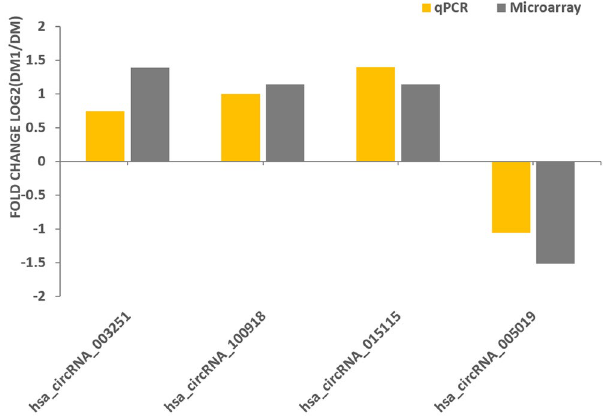
Figure 2. Validation of the four differential expression circRNAs. The expression levels of the following hsa _circRNAs were analysed by qRT-PCR: hsa_circRNA_003251, hsa _circRNA_015115, hsa _circRNA_100918, and hsa_circRNA_005019. The heights of the columns represent the fold changes (log2 transformed) computed from the qPCR and microarray